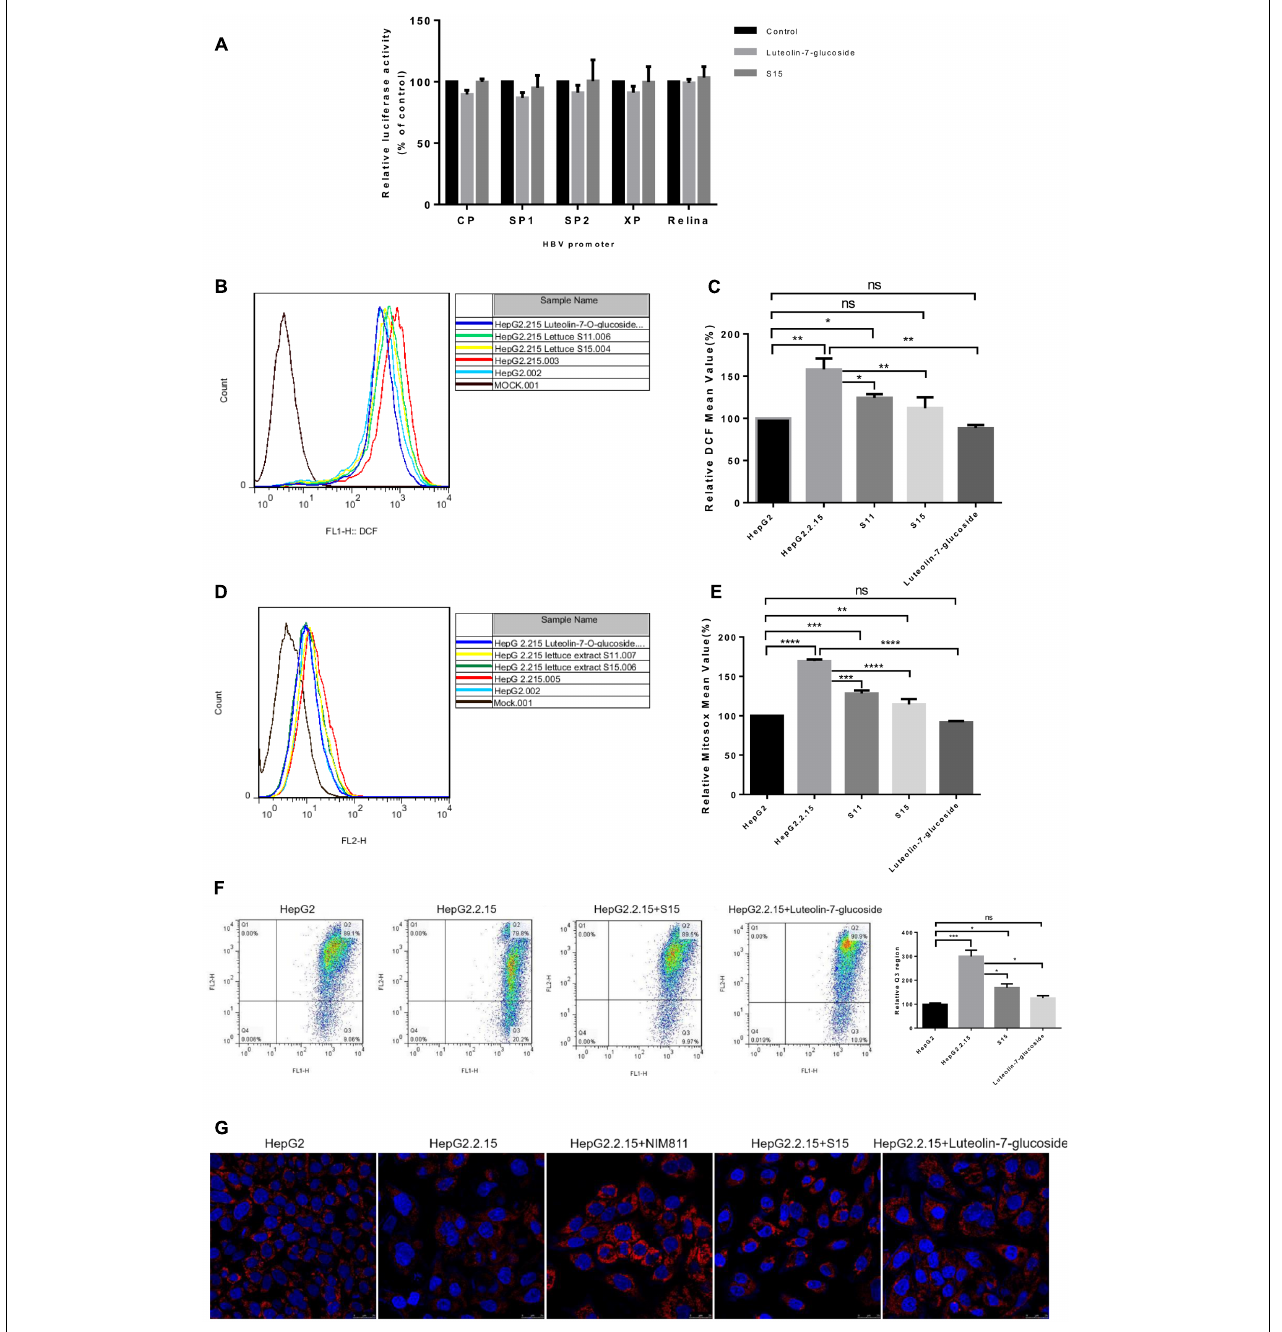
FIGURE 5 | Reactive oxygen species and mitochondrial membrane potential measurement after treatment of HepG2 2.2.15 cells with lettuce extracts and luteolin-7- O -glucoside to explore the mechanism of anti-HBV. The lettuce extracts and luteolin-7- O -glucoside have no effect on the activities of HBV promoters in HepG2 cells (A) and influence intracellular redox (B,C) status and mitochondrial membrane potential (D,E) . HepG2 cells were transient transfected with the luciferase reporter plasmids with HBV promoters Sp1, Sp2, ENII/Cp, and ENI/Xp. A control of Relina (Promega, Madison, WI, United States) was used to exclude non-specific toxic effects of the treatment. Luciferase activities were determined using the luciferase assay. HBV-producing cell line HepG2.2.15 and HepG2 cell line were stained with DCFH (B,C) and MitoSOX Red (D,E) probes and ROS levels were determined by FACS. Besides, the mitochondrial membrane potential was quantified by JC-1 dye using FACS (F) . Means and SDs of data from three independent experiments are plotted. Detection of mitochondrial membrane potential of HepG2.2.15 using MitoRed dye (G) by confocal microscopy. The fluorescence intensity of HepG2.2.15 became stronger after treatment with lettuce extract S15 and luteolin-7- O -glucoside. NIM811 could be the positive control of stabilize the mitochondrial membrane potential. All values are expressed as percentages relative to untreated control. Statistical significance was calculated using student’s t -test. Ns, not significant, ∗ P < 0.05, ∗∗ P < 0.005, ∗∗∗ P < 0.0005, ∗∗∗∗ P < 0.0001.